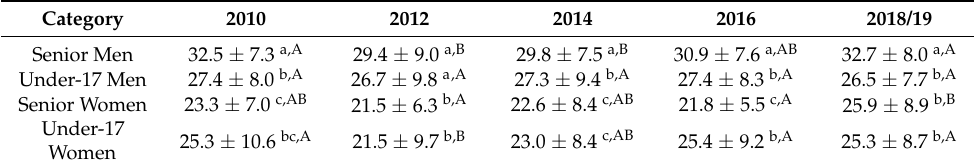
Table 3. Means and SDs of three-point shot attempts per 100 possessions.